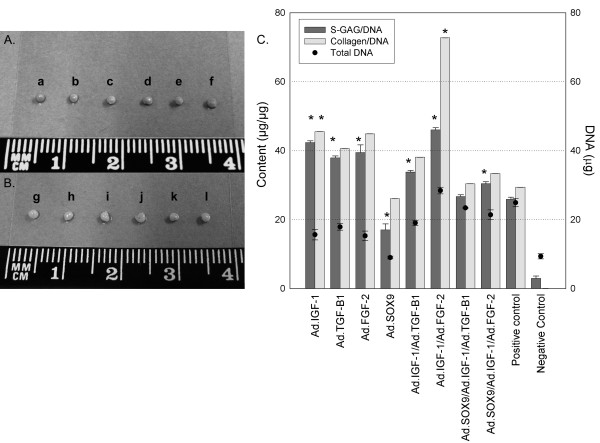
Western blot and densitometry analysis. (A) Western blot analyses at day 28 post transduction for in vitro expression of collagen (COL) I, COL II and COL X. (B) Densitometric analysis illustrating COL/glyceraldehyde-3-phosphate dehydrogenase (GAPDH) expression ratio (Phoretix 1D software; TotalLab Ltd, Newcastle, UK). Adipose-derived stem cells (ASCs) transduced with Ad.IGF-1/Ad.FGF-2 (multiplicity of infection 50 for each vector) showed almost threefold increased expression of COL II compared with the positive control. Similar low expressions of COL × were observed in adenoviral transduced ASCs and the positive control. Expression of COL I was undetected in the experimental groups. FGF-2, fibroblast growth factor-2; IGF-1, insulin-like growth factor-1; WB, positive control for type I collagen from cultured osteoblasts.